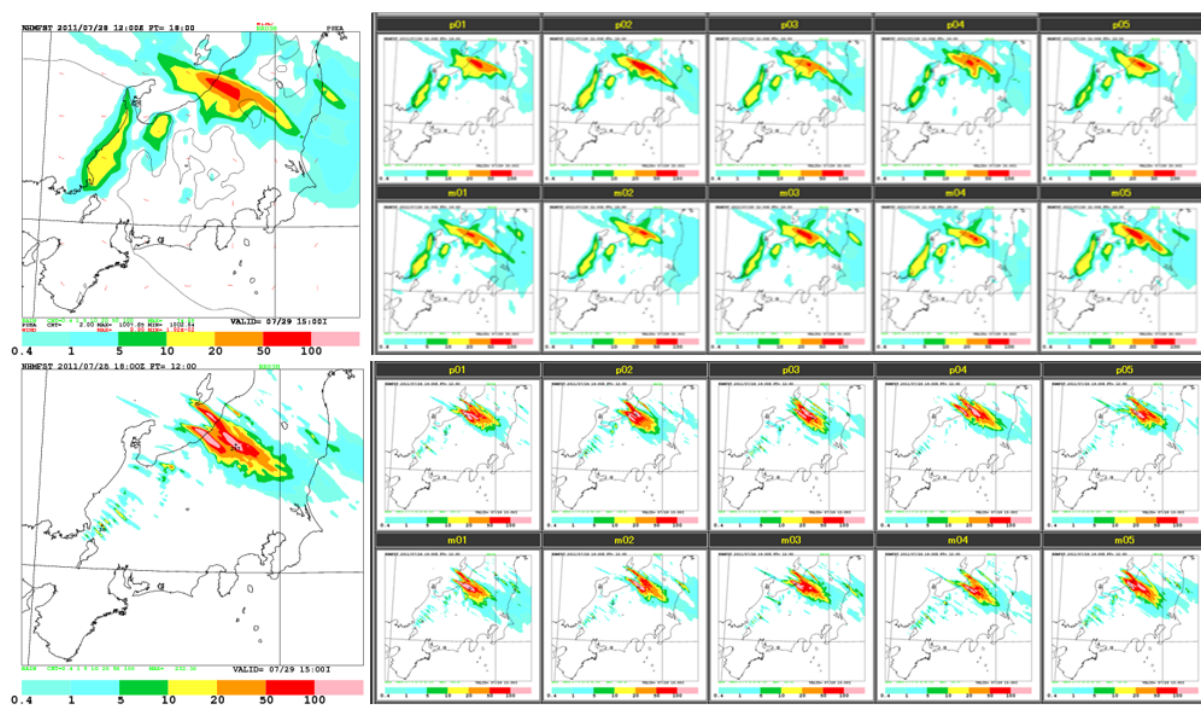
Figure 9. Three-hour accumulated rainfall from 12:00 to 15:00JST (03:00 to 06:00UTC) on 29 July by the control run of the 10km EPS (upper left). Same as in the left figure, but the forecast by each member of the 10km EPS (upper right). The figures on the lower left and right are the same as in the upper figures but for the forecasts by the 2km EPS.